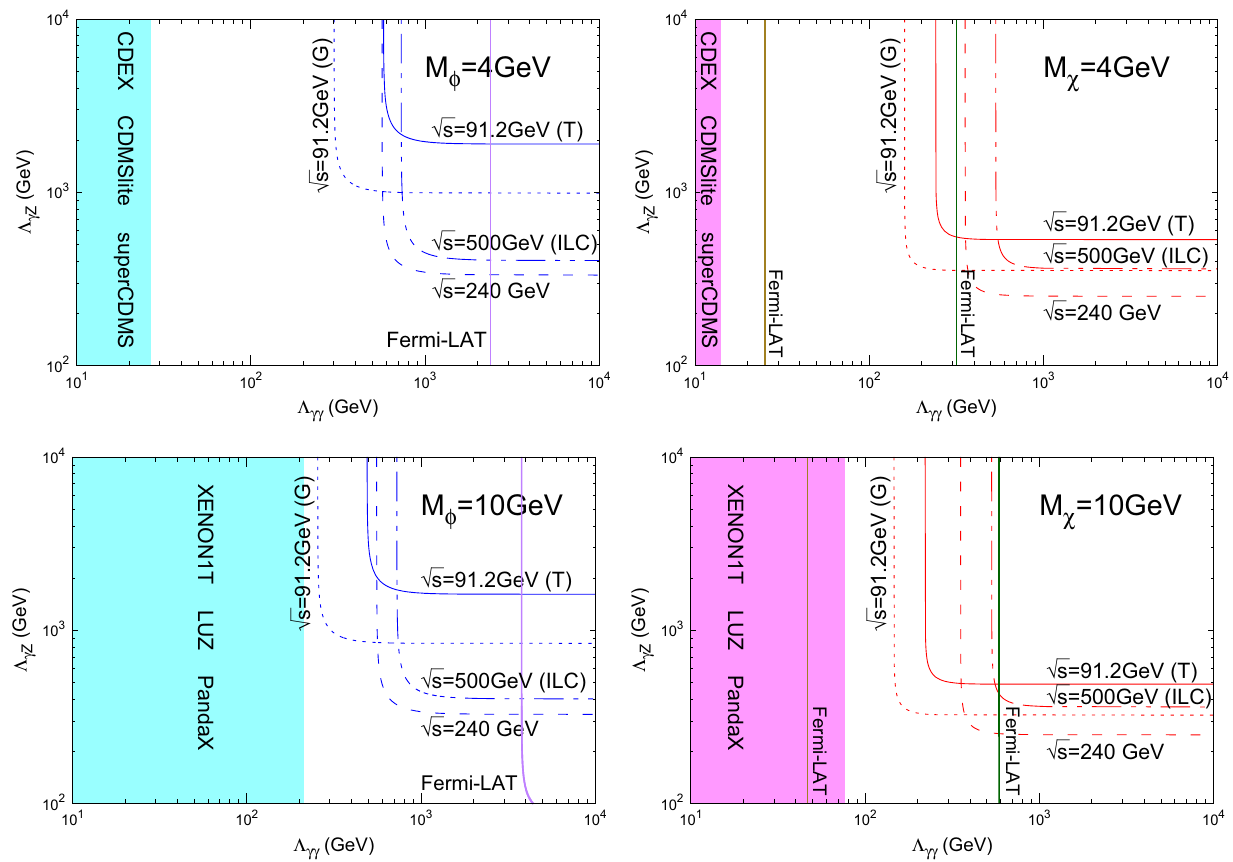
Fig. 7 Limit on Λ γγ − Λ γ Z for direct, indirect and collider detection. In the left (right) panel, the DM is scalar (fermion) with show-case masses m φ,χ at 4 and 10GeV. The cyan, magenta dash areas denote direct detection constraints for scalar DM and fermion DM with scalar type. The constraints from direction detection are SuperCDMS, CDEX, CDMSlite,XENON1T,LUXandPandaX.Thepurple,olive,darkgreen solid lines denote Fermi-LAT constraint from R3 region, where they denote scalar DM, fermion DM with scalar and pseudo-scalar types,